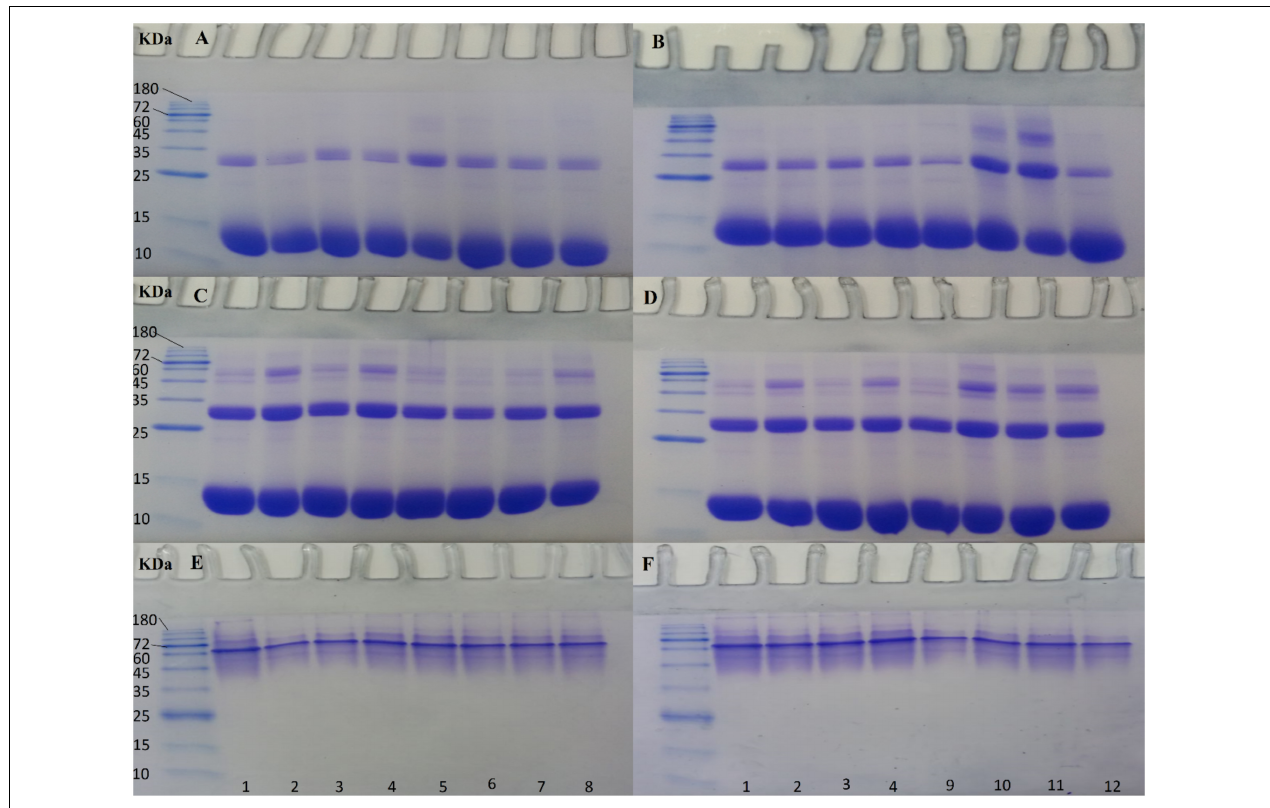
FIGURE 7 | SDS- and Native-PAGE analyses of non-ozonated and ozonated Hb samples in the presence of phosphate buffer and diluted versions with different water types. Samples 1 to 4: non-ozonated Hb samples in phosphate buffer, deionized water, double distilled water, and tap water, respectively. Samples 5 to 8: ozonated Hb samples at 55 µ g/ml in phosphate buffer, deionized water, double distilled water, and tap water, respectively. Samples 9 to 12: ozonated Hb samples at 80 µ g/ml in phosphate buffer, deionized water, double distilled water, and tap water, respectively. The samples in SDS-PAGE gels (A) and (B) are in the presence of DTT and in gels (C) and (D) in the absence of DTT. Samples in Native-PAGE gels (E) and (F) are under native